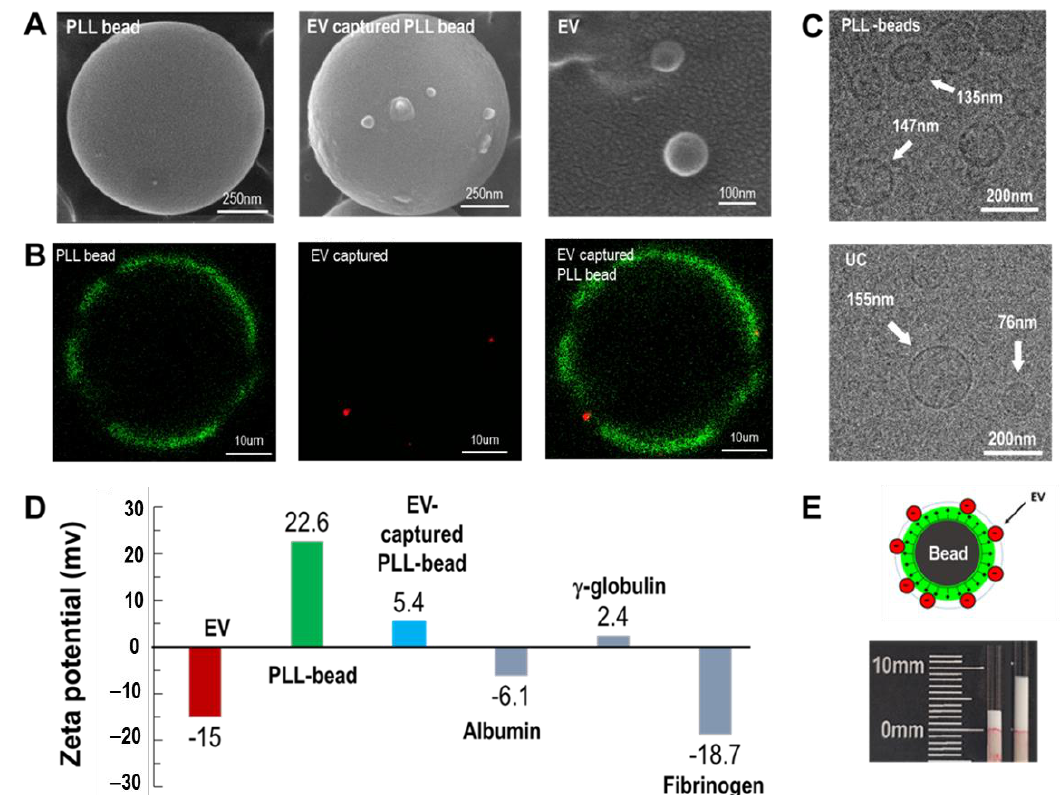
Figure 2. EV isolation using cationic polymer-coated beads. ( A ) SEM images of a PLL-coated bead, an EV-captured PLL bead, and isolated exosomes, respectively. The mean size of the magnetic beads was 950 nm. ( B ) Fluorescent images of PLL-coated magnetic beads (green color), exosome capture by PLL bead (red color), and the merged image. ( C ) Cryo-TEM images of EVs eluted from PLL beads and ultracentrifugation (UC). ( D ) Zeta potentials of exosomes, PLL beads, EV-bound PLL beads, and plasma proteins, including albumin, γ-globulin, and fibrinogen. ( E ) Volume-change analysis after incubating PLL beads with blood plasma.